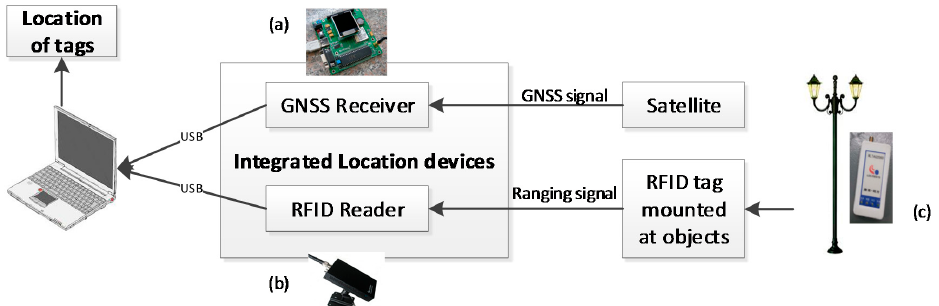
Figure 1. The hardware of the location system. ( a ) Global Navigation Satellite System (GNSS) receiver; ( b ) radio frequency identification (RFID) reader; ( c ) RFID tags. ( b ) radio frequency identification (RFID) reader; ( c ) RFID